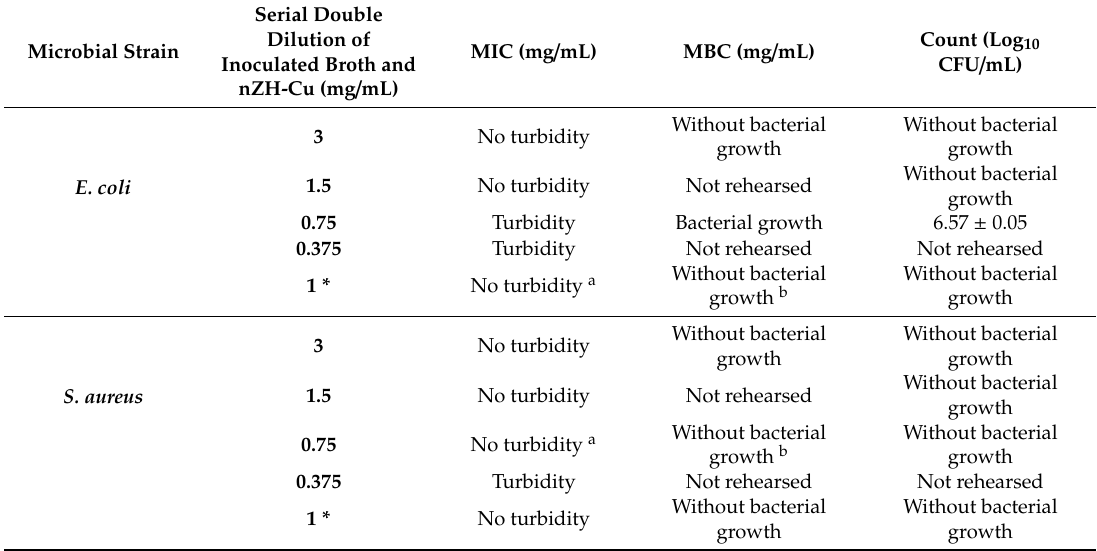
Figure 9. Determination of the MIC by double serial dilution against E. coli and S. aureus . ( a ) Using 3 and for 1 mg / mL of nZH-Cu. ( b ) Using 3 and 1 mg / mL of nZH. Table 4. MIC and MBC of nZH-Cu and colony count through the serial double dilution turbidity determination assay and microdrop concentrations of 3, 1.5, and 1 mg/mL of the nZH-Cu sample, there was no turbidity. This means that there was no bacterial growth. The MIC achieved with 1 mg/mL of the nZH-Cu sample was verified,